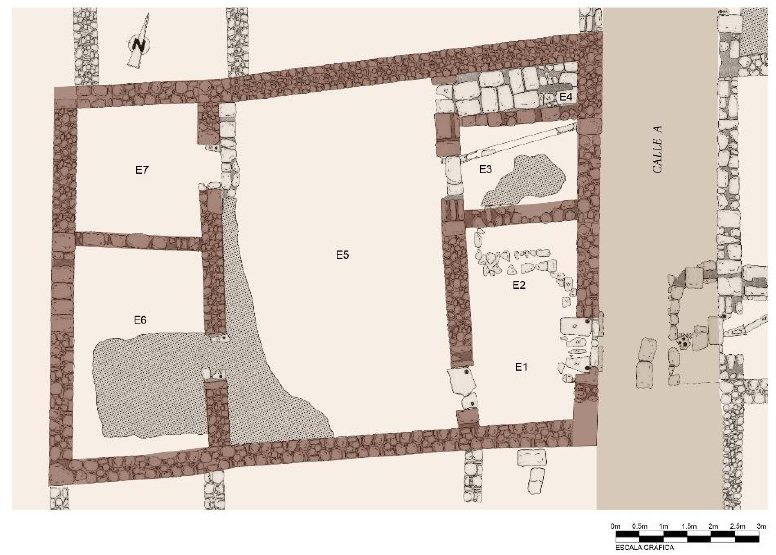
Figure 19. Variant 3. House 9. Plan and room distribution (Aparicio Sánchez 2020, Figure 20).